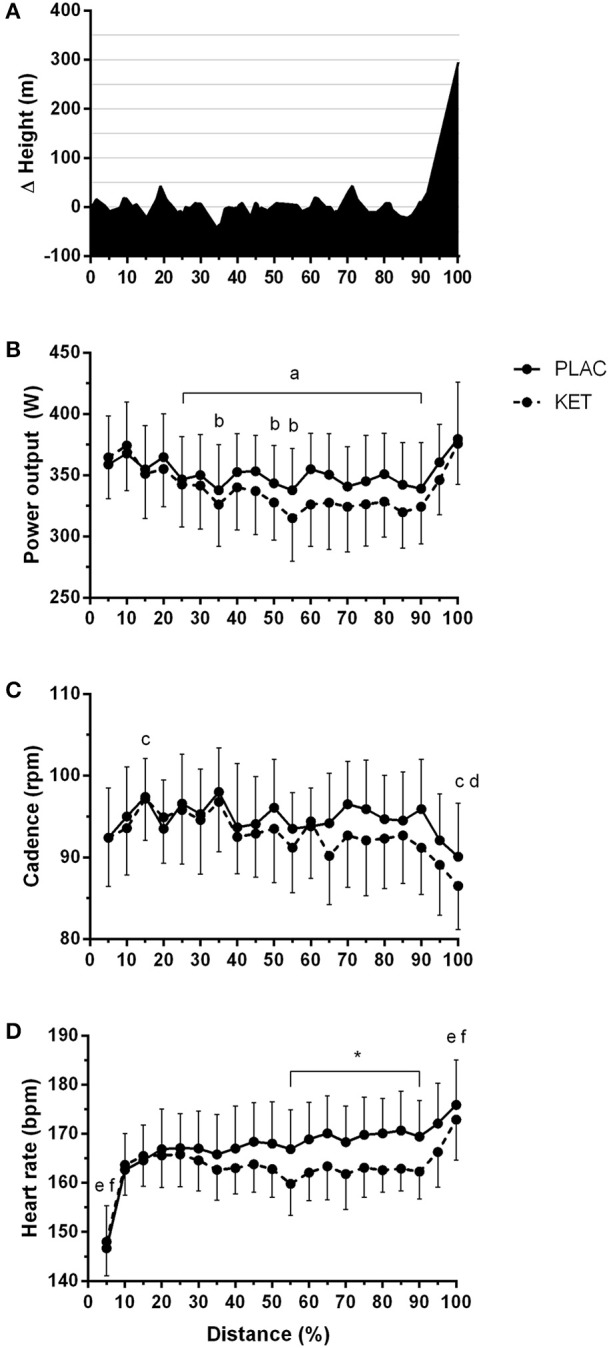
Course profile of World Championships TT course (Bergen, Norway) (A), average power output (B), cadence (C), and heart rate (D) during TT as a percentage of total distance, following exogenous KET or PLAC ingestion. Values are mean ± SD. a different to 5% in KET; b different to 5% in PLAC; c different to 10% in KET; d different to 10% in KET; *KET different to PLAC, e different to all other time points in KET, 50% different to f.